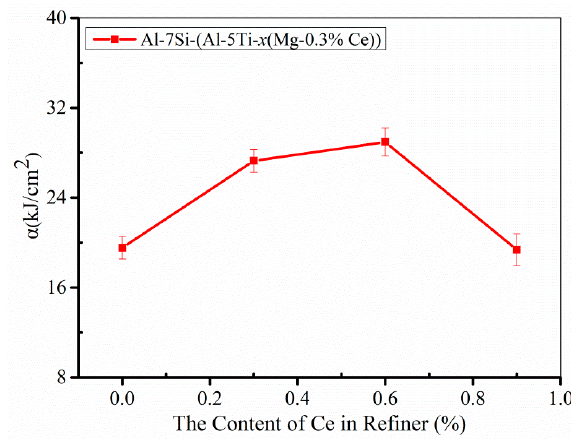
Figure 14. The impact toughness change diagram of specimen.